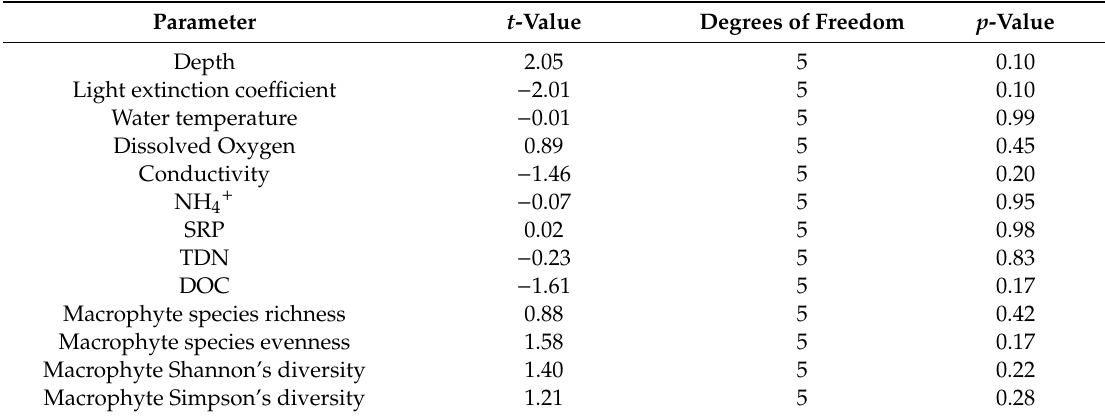
Table 2. Two-sided paired t -tests results for +IWM vs. − IWM plots.